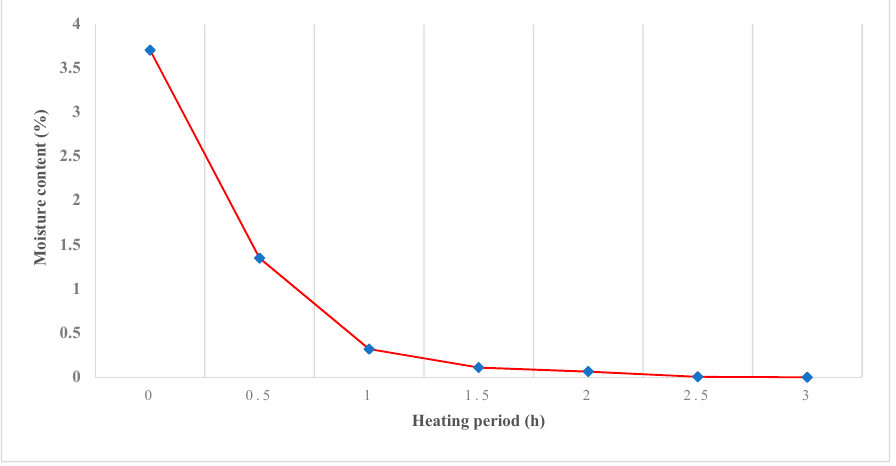
Figure 1. The effect of the heating time on the RAP moisture content.